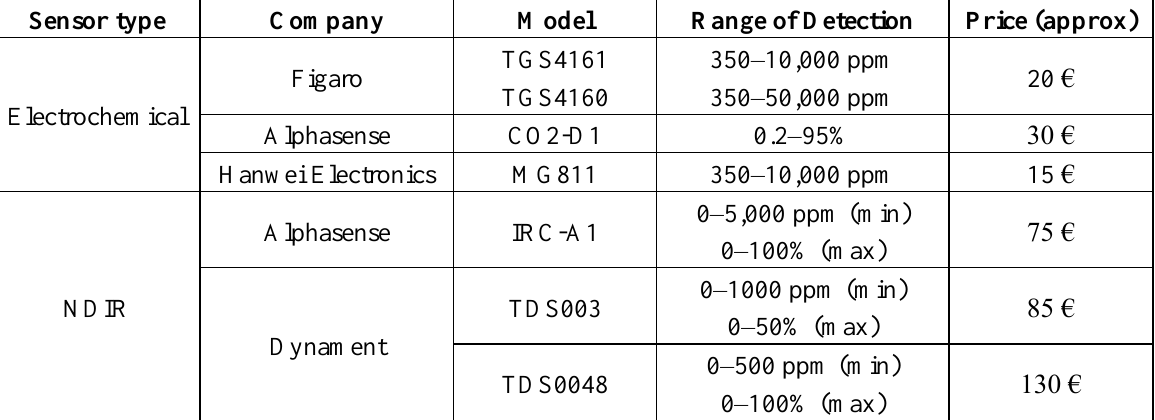
Table 1. Some electrochemical and NDIR sensors available for carbon dioxide detection